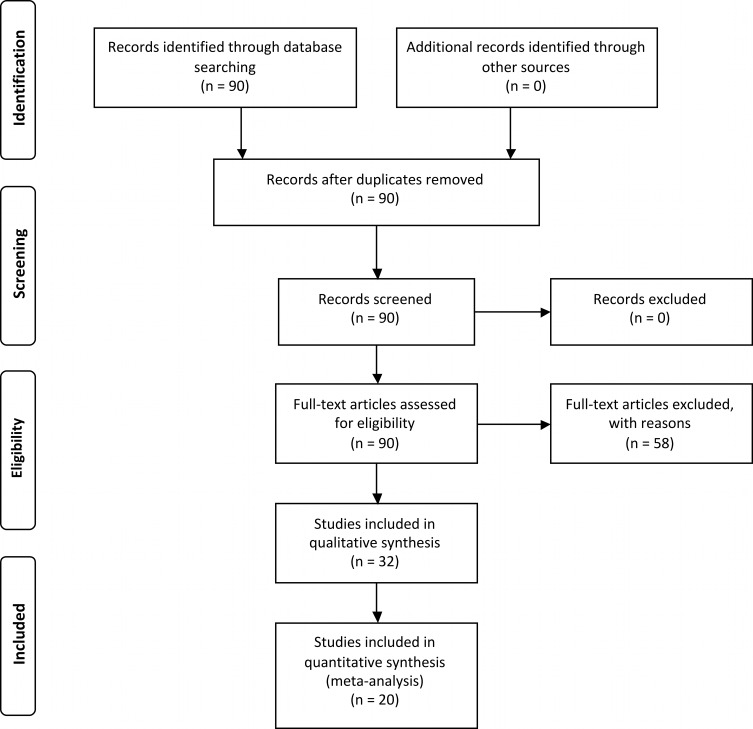
Prisma flow diagram (Moher et al., 2009) depicting the seach protocol and workflow in determining the effective population of studies for systematic review and meta-analysis.